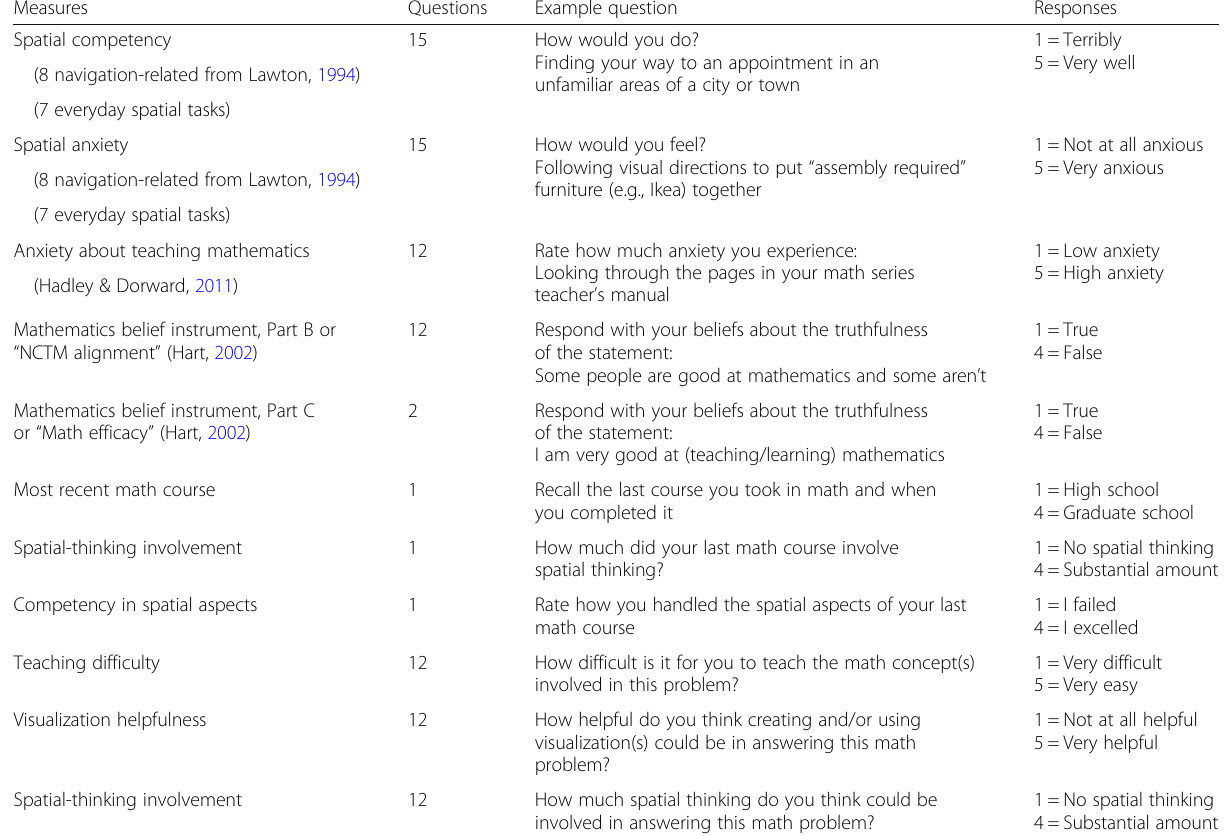
Table 3 Measures used along with number of questions, and example question, and range of responses